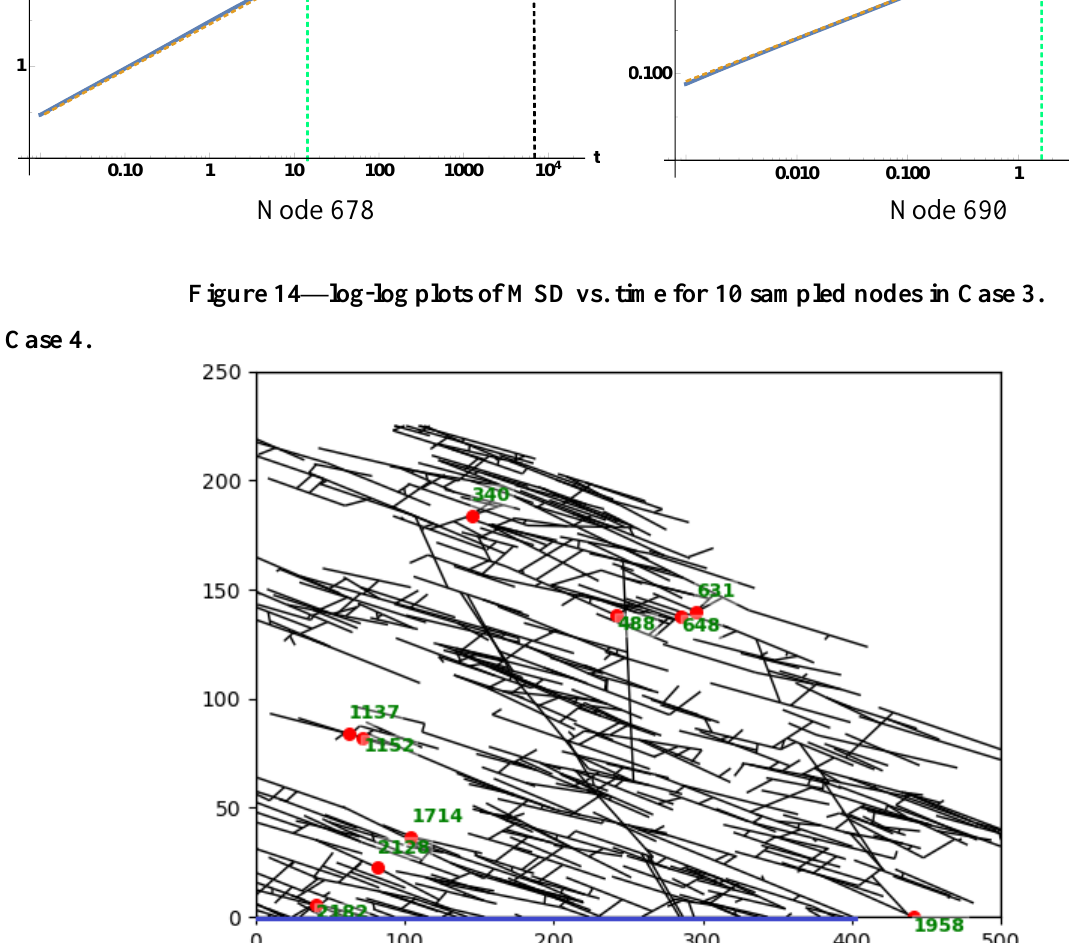
Figure 15—Map view plot of the fracture network and 10 sampled nodes in Case 4.